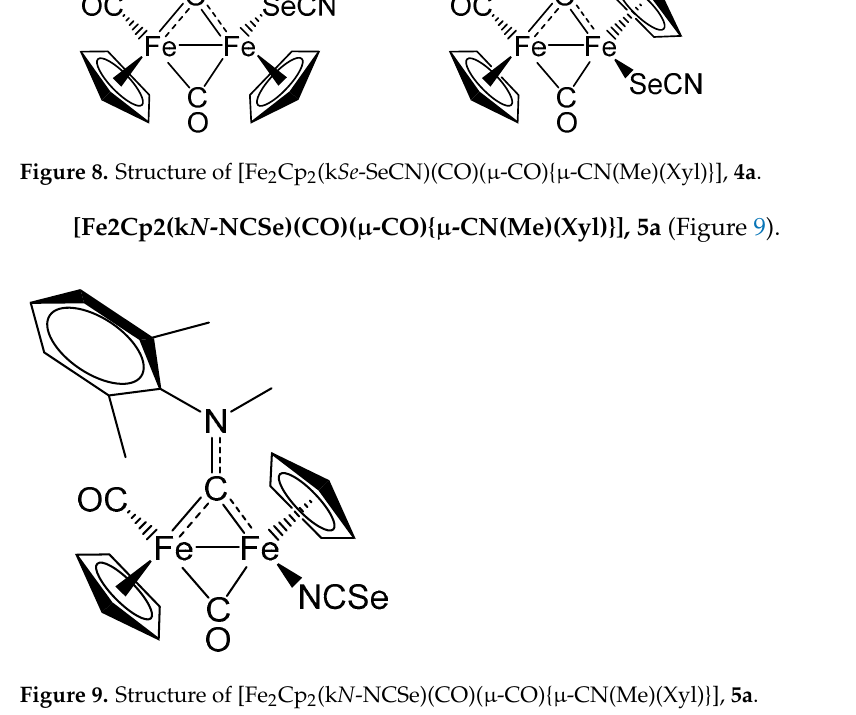
Figure 5. Structure of [Fe 2 Cp 2 (k N- NCO)(CO)(µ-CO){µ-CN(Me)(Me)}], 2b [39].